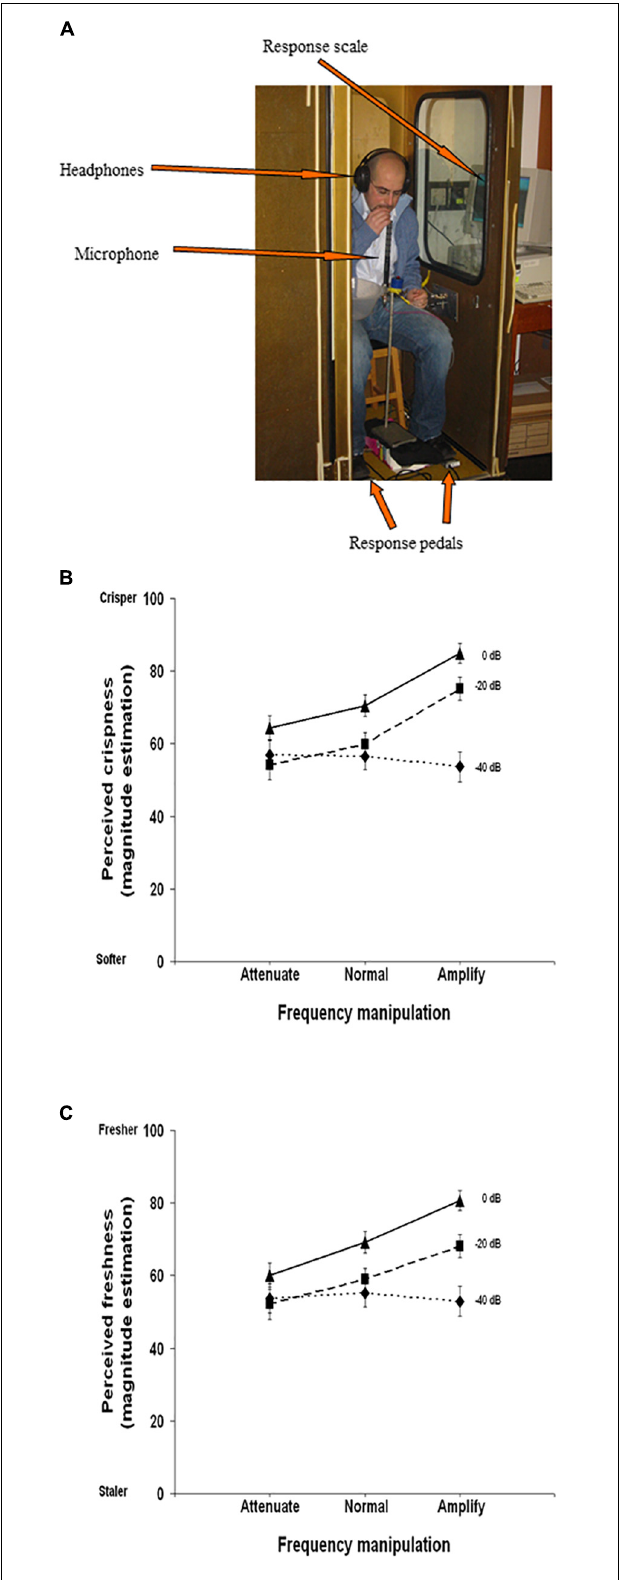
FIGURE 6 | Experimental set-up and results from Zampini and Spence’s (2004) study demonstrating the influence of manipulating biting sounds (airborne component) when biting into a potato chip. (A) Experimental set-up of participant; note that during testing, the booth door was closed and participants provided responses via computer screens situated through the wall (left-hand side) of the booth. (B) Perceived crispness of the chip ( y -axis) during sound frequency alteration ( x -axis) and 3 sound intensity conditions (0 dB, –20 dB, –40 dB). Results show that amplifying the high frequency components of the sound increased perceptions of crispness (unless sound is very quiet: –40 dB), and decreasing sound intensity increase perceptions of chip softness. (C) Perceived freshness of the chip ( y -axis) during sound frequency alteration ( x -axis) and 3 sound intensity conditions (0 dB, –20